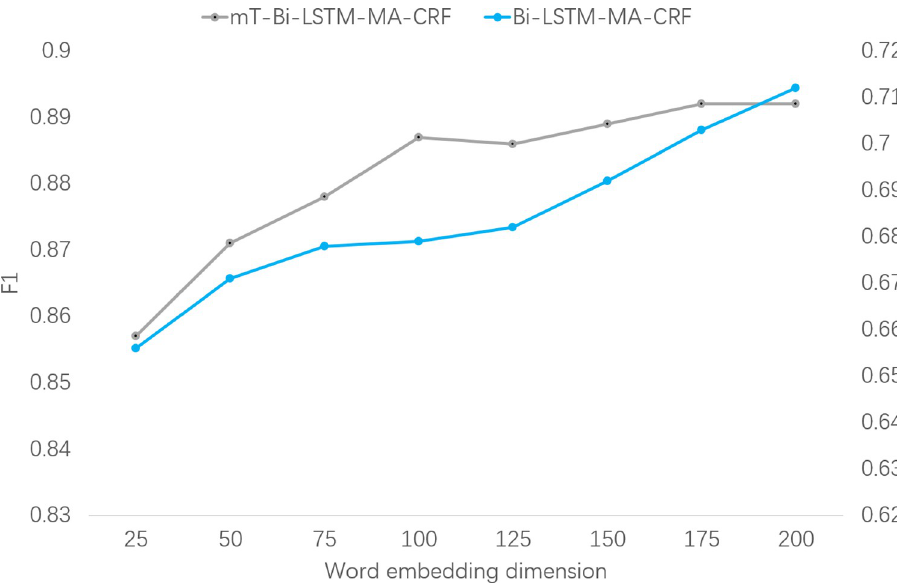
Fig 5. The F1 scores for different word embedding dimensions. A black dotted line and a blue dotted line represent the F1 score of the proposed model and the Bi-LSTM-MA-CRF model, respectively. The vertical axis of the black line is on the left, whereas the vertical axis of the blue line is on the